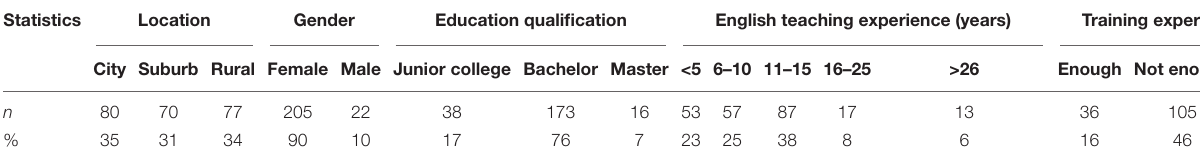
TABLE 4 | The characteristics of the questionnaire respondents ( n = 227).